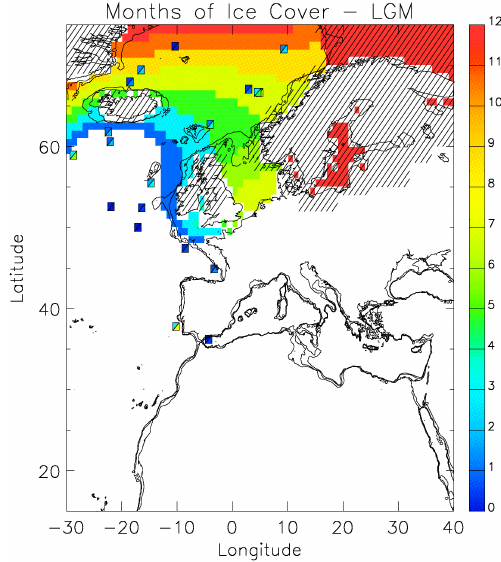
Figure 9. Months of ice cover from LGM (Paul and Schäfer-Neth, 2003) with glacier template at 21 ka before present indicated by hatching (Peltier, 1994). The LGM bathymetry (sea level and 200 m depth) is derived from the 1° sea level data of Peltier (1994) at 21 ka before present, interpolated to the 5’ fields of ETOPO-5. The present-day coastline is indicated on the map. The small boxes give a more recent assessment (De Vernal et al., 2005) of the average number of months of sea ice (top left triangle gives the average number of months; the lower right triangle gives the average-plus-one- standard-deviation). During the LGM, the Nordic seas may have been mostly ice-free during the summer